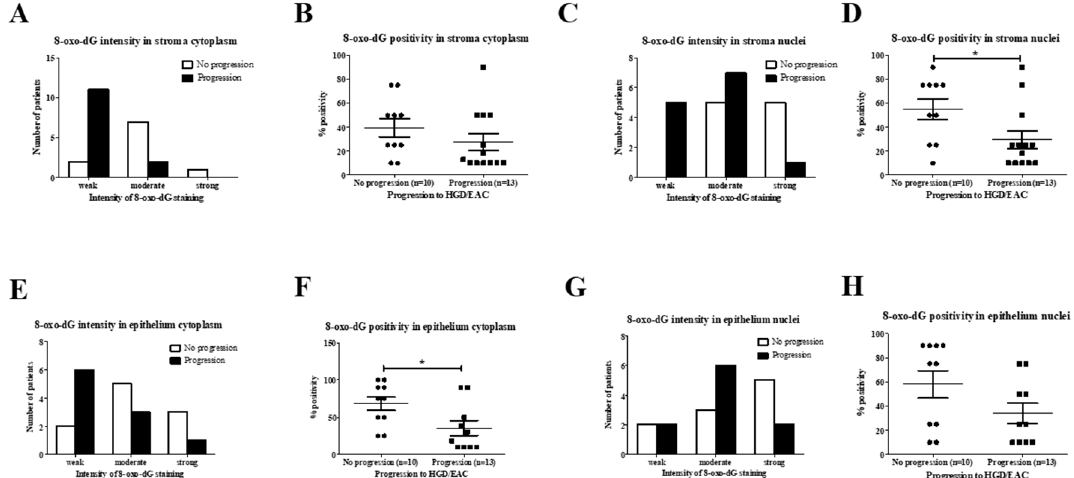
Figure 6. ( A – H ): 8-oxo-dG staining in SIM progressors and non-progressors. ( A ) Chi-square test demonstrated significantly weaker intensity of 8-oxo-dG staining in patients with progressive disease ( p = 0.008). ( B ) Mann–Whitney U test showed no di ff erence in the percentage of stroma cytoplasm positive for 8-oxo-dG ( p = 0.168). ( C ) Chi-square test showed weaker 8-oxo-dG staining in the progressors ( p = 0.0201). ( D ) Non-progressive Barrett’s esophagus (BE) was associated with an increased percentage of positive stroma nuclei ( p = 0.039). ( E ) Chi-square test showed no di ff erence in staining intensity in epithelial cytoplasm ( p = 0.174). ( F ) Epithelial cytoplasm percentage positivity was significantly higher in the non-progressing group ( p = 0.030). ( G ) Chi-square test demonstrated no di ff erence in 8oxo-dG intensity in epithelial nuclei between both groups ( p = 0.320). ( H ) Mann–Whitney U test showed no di ff erence in percentage positivity of 8-oxo-dG epithelial nuclei ( p = 0.100). * p < 0.05.